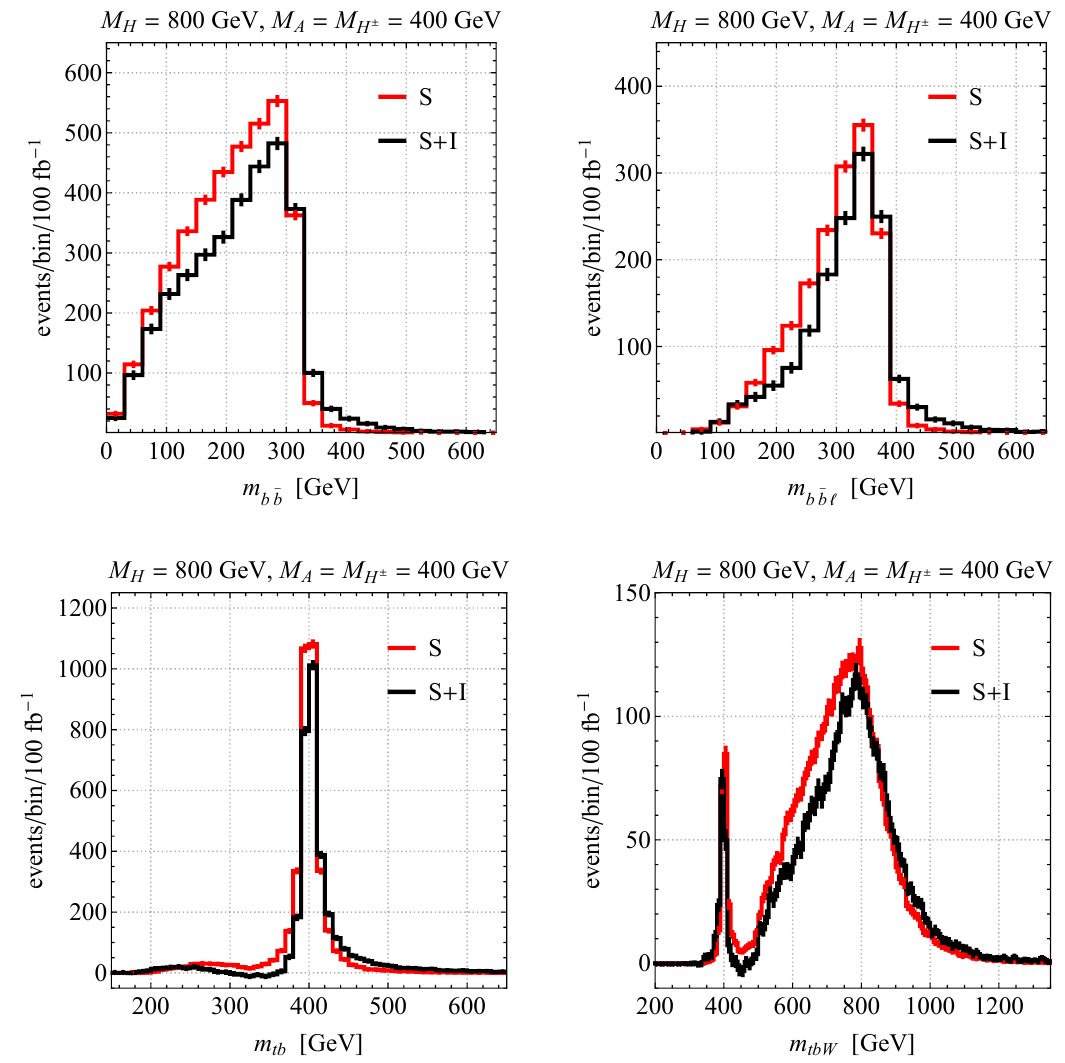
(upper left panel), m (upper b (cid:22) b b (cid:22) b‘ = 400 GeV, c (cid:12) (cid:0) (cid:11) = 0 H (cid:6) p s = 14 TeV ignoring (S)